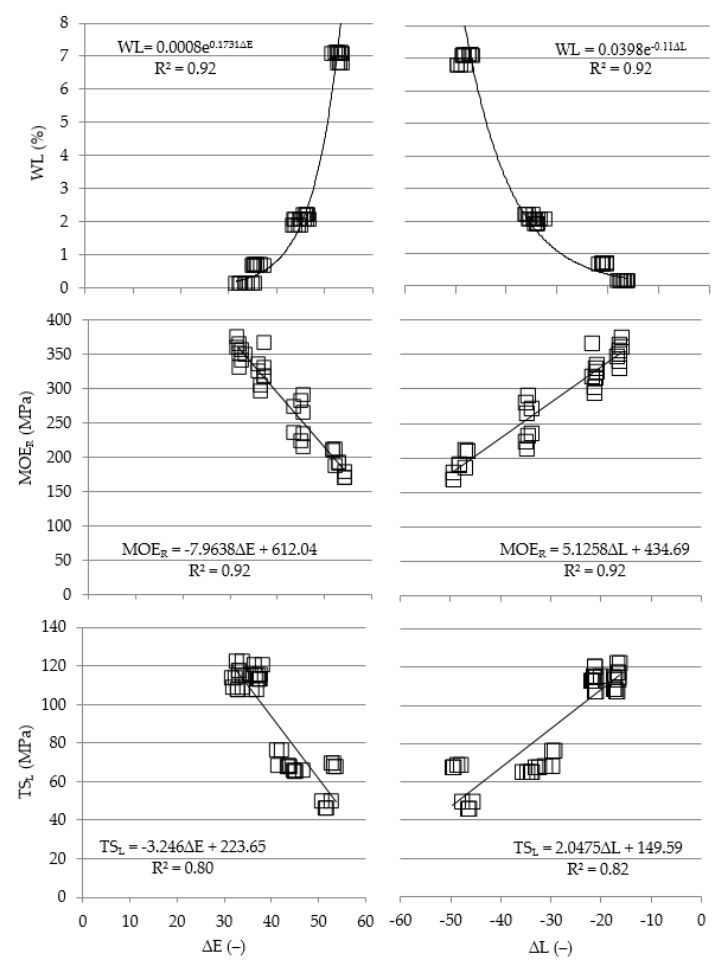
Figure 5. Values of WL, MOE R and TS L in the function of total color difference (∆E) and difference in lightness (∆L).